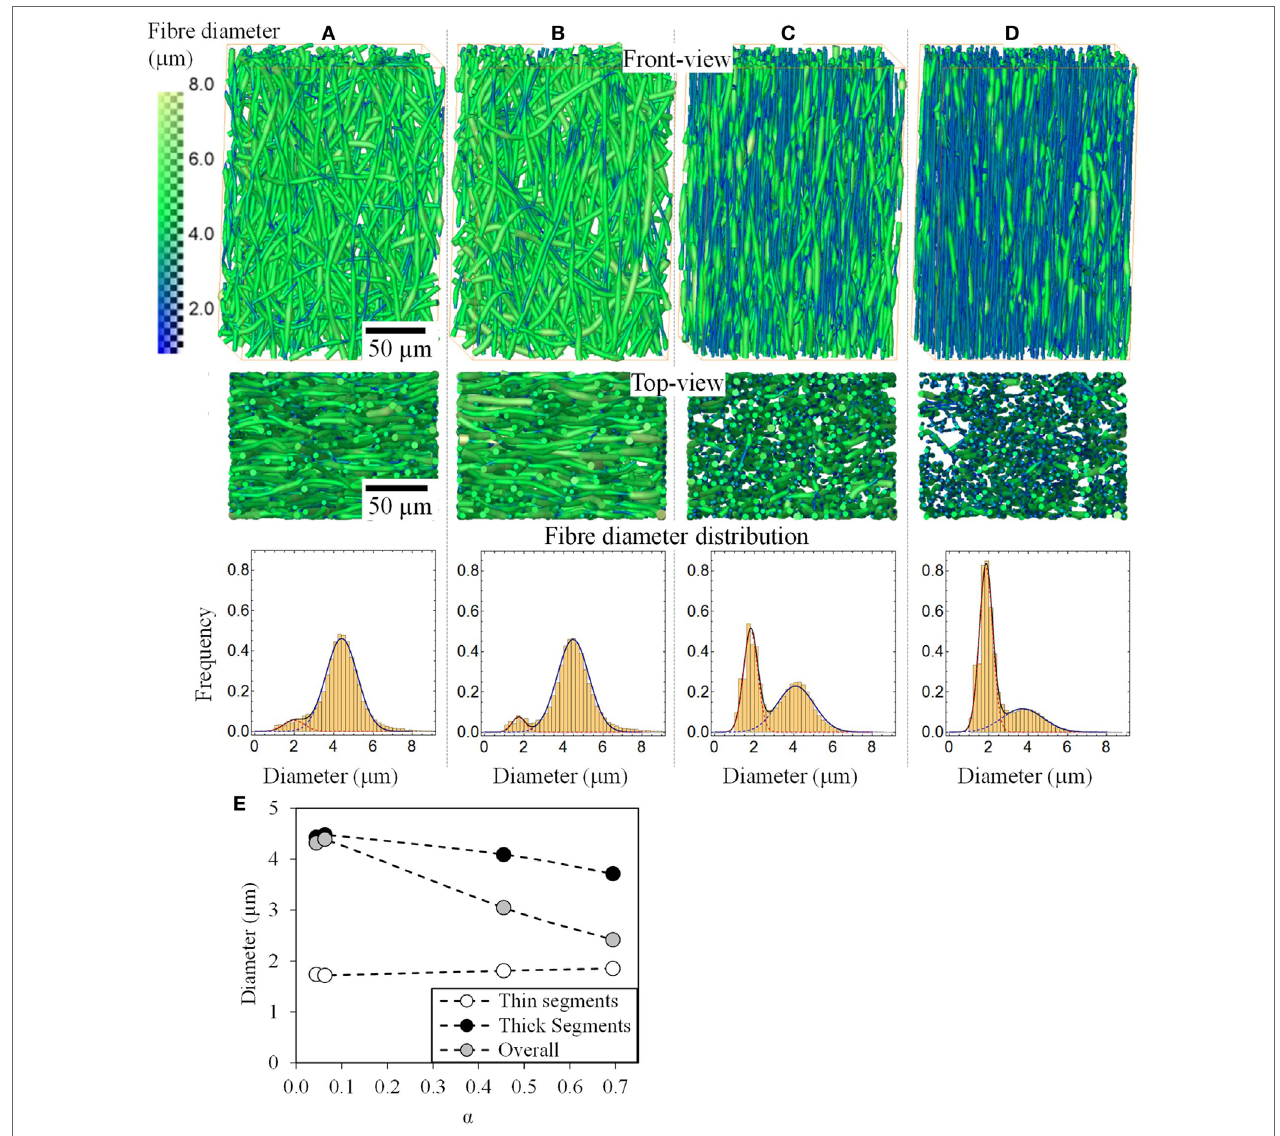
FigUre 5 | Front and top view 3D rendering of small volumes of the P(3HB-co-4HB) fiber mats and fiber diameter distributions for the unstrained (a) , 33% (B) , 193% (c) , and 352% strained (D) . The color map on the left represents fiber diameter in micrometers. The fiber diameters could be fitted with a bimodal Gaussian distribution. The modes of the overall and the two distributions are also plotted in (e) as a function of their fraction ( α